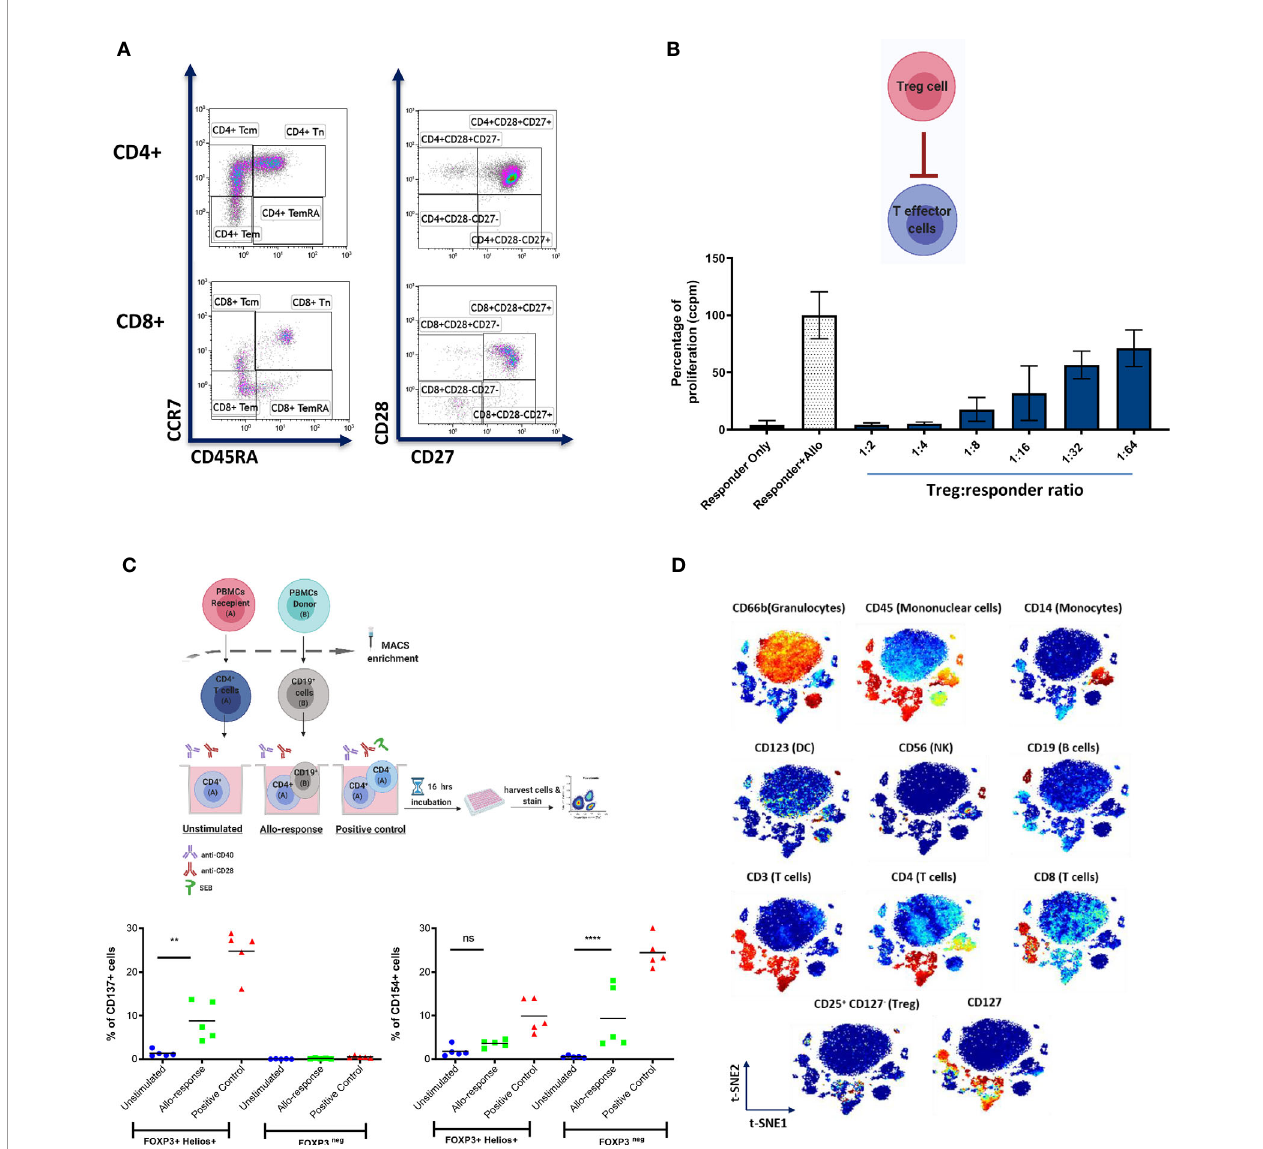
FIGURE 2 | Representative examples of systemic immune monitoring techniques. (A) Flow cytometry can be used to measure the frequency of various immune cell populations in peripheral blood. (B) In vitro suppression assays can be used to assess the suppressive potential of Tregs (or other regulatory cells). Example of 3H- thymidine incorporation readout in a test with allogeneic stimulation. (C) (Top) Schematic of the experimental design of CD137/CD154 assay. (Bottom) Example of CD137 (left) and CD154 (right) expression on FOXP3 + Helios + (Tregs) and FOXP3 neg (conventional CD4+ T cells) cells. (D) Multiplexed CyTOF technology can be used for deep phenotyping analysis of leukocyte composition. An example of t-distributed Stochastic Neighbor Embedding (t-SNE) analysis of leukocyte clusters annotated based on the intensity of analyzed parameter is shown. ** = p value 0.0041, **** = p value < 0.0001, F test of variance. not signi fi cant (p